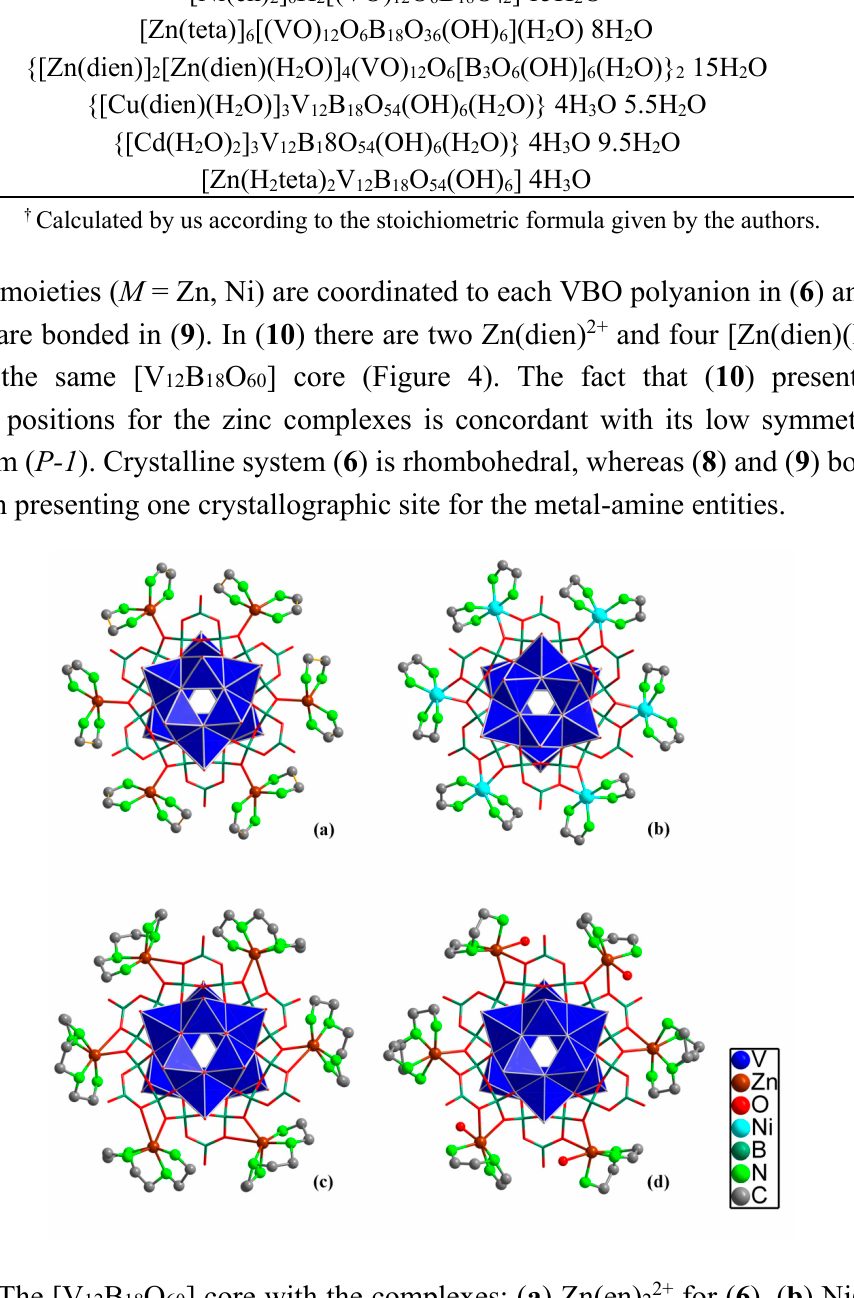
V IV /V V Ref. Ratio